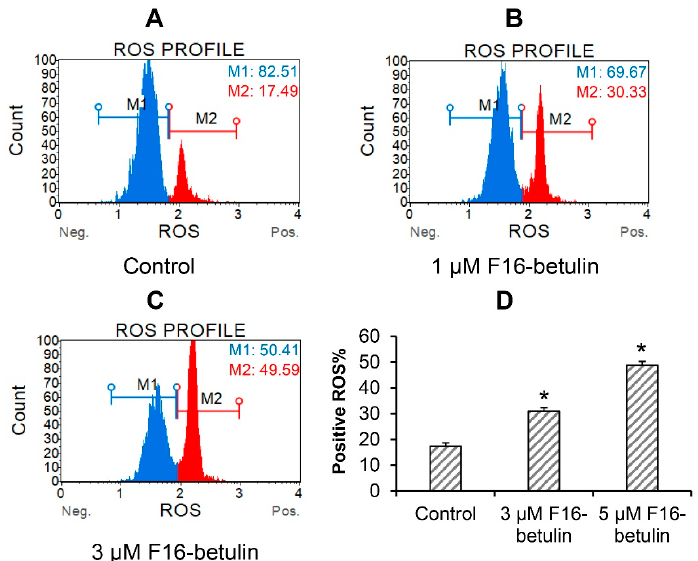
Figure 3. Reactive oxygen species (ROS) burst in thymocytes induced by the F16-betulin conjugate. The ROS profile was assessed using the Muse Oxidative Stress kit (superoxide sensitive). Typical ROS profile plots ( A – C ) are shown. A similar pattern was observed in three independent experiments. Panel ( D ) demonstrates the percentage of dihydroethidium-stained (ROS positive) cells (means ± SEM; n = 3). * p < 0.05 (vs. control).